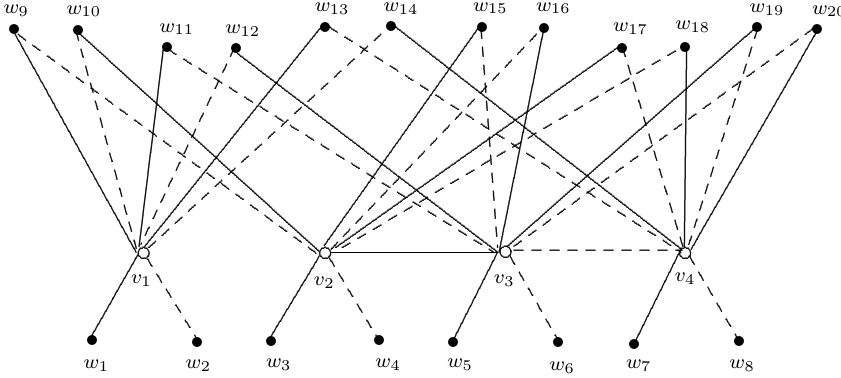
Figure 6: A subgraph F of K